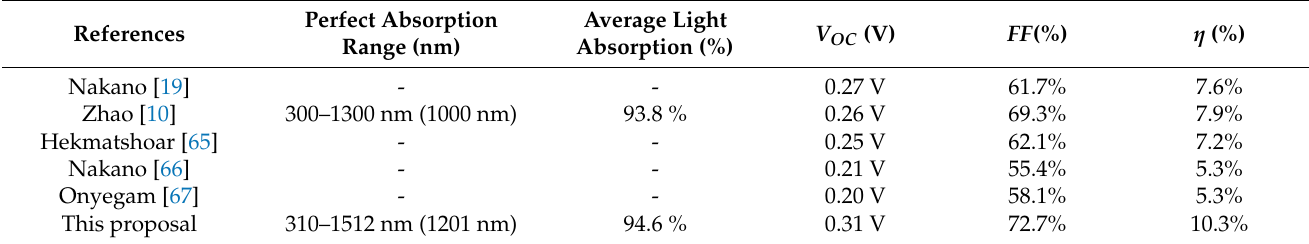
Table 1. Comparison of performance of different Ge micro-nanostructured solar